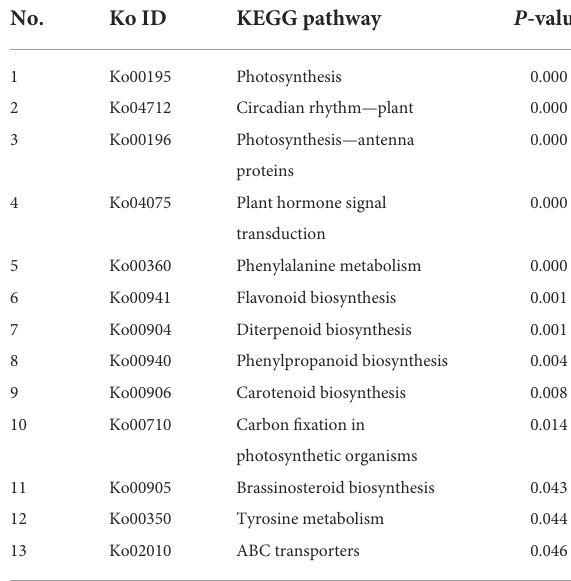
TABLE 5 The enriched pathways of differentially expressed genes (DEGs) compared 3d + S-0h vs. 3d + S-12h in KEGG analysis.